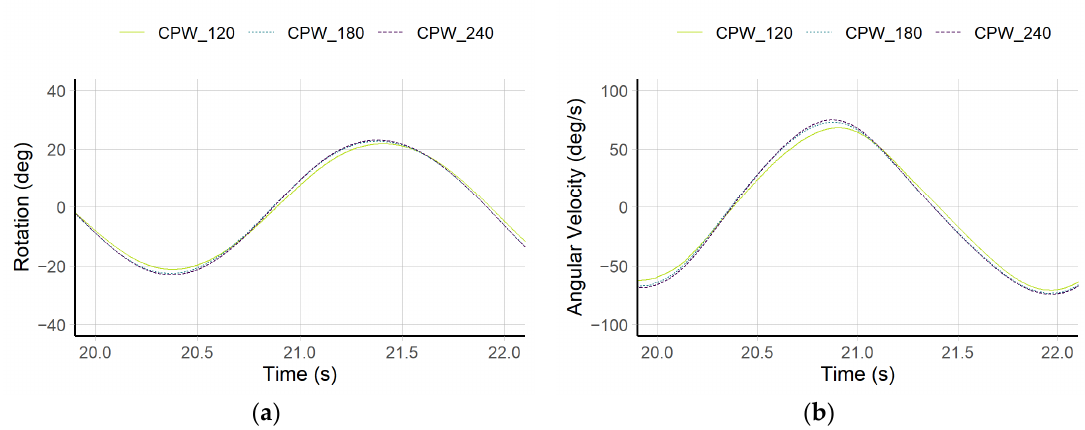
Figure 6. Influence of varying mesh density in the: ( a ) Rotation angle, ( b ) angular velocity.